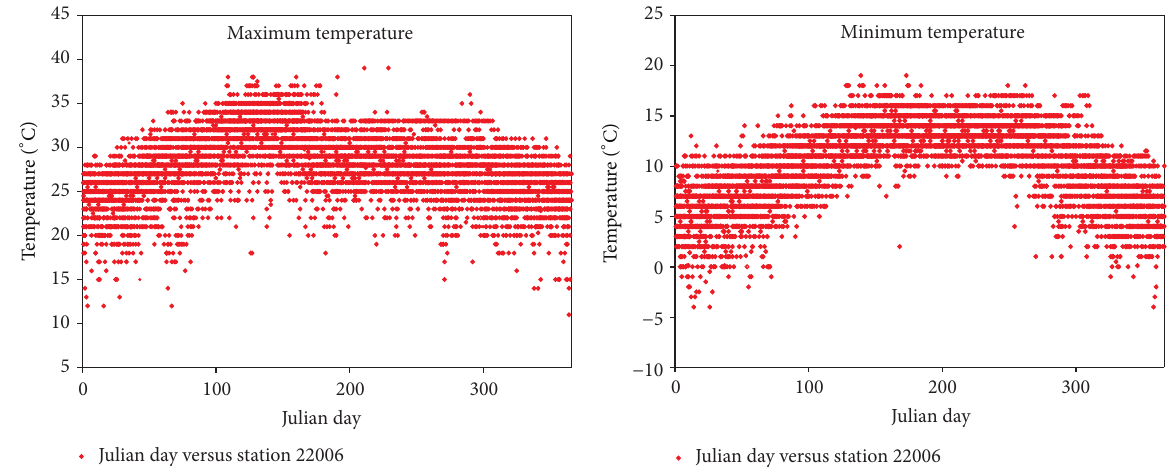
Figure 3: Maximum and minimum daily temperature for El Pueblito (ID 22006) weather